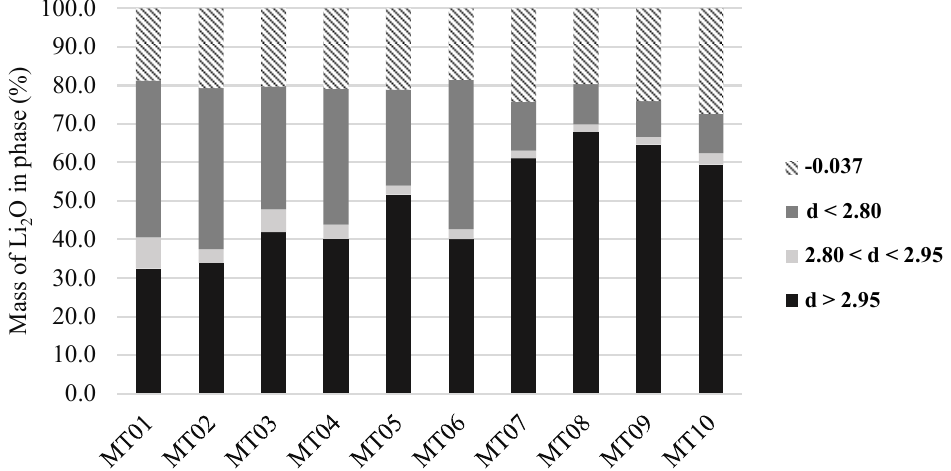
Figure 3. Mass percentage of Li 2 O in the density separation products and in a fraction under 0.037 mm.